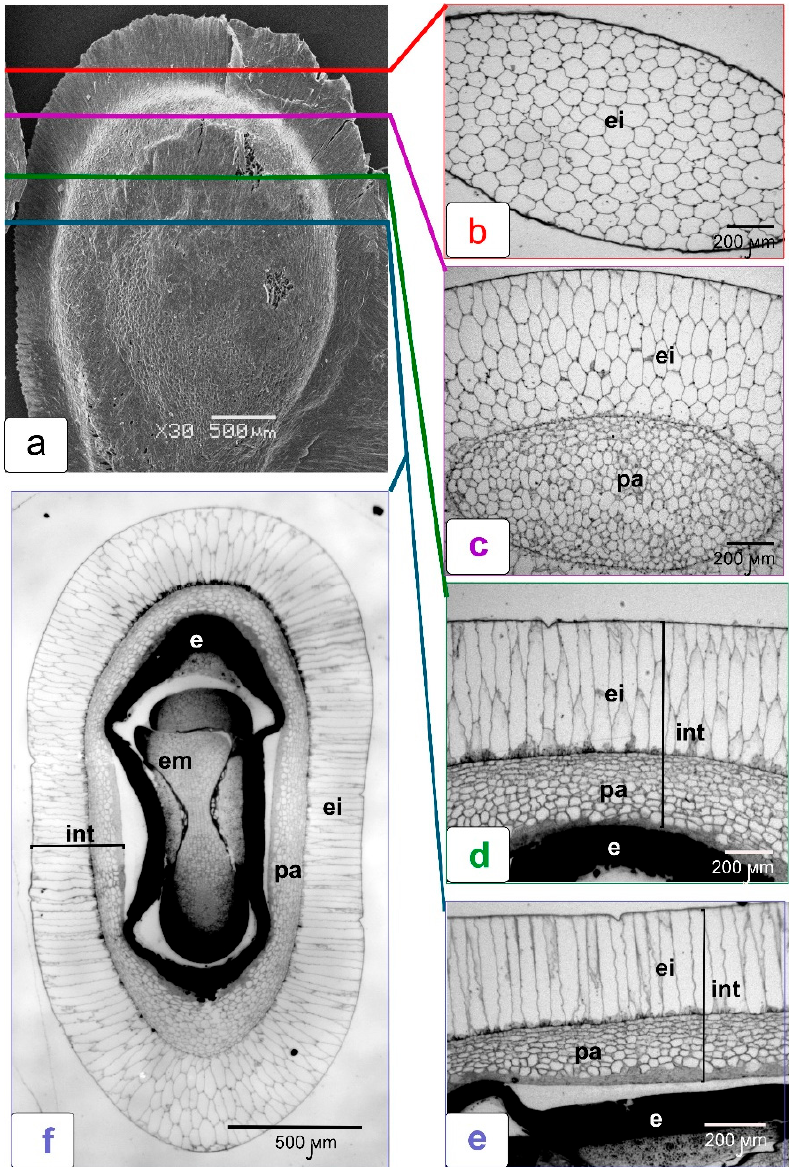
Figure 5. The light microscopy of the seed structure from a close-to-ripening green tomato fruit on cross sections. Sectioning locations (instead of a diagram) are shown in the seed image taken on scan ( a ). Transverse semi-thin sections of seeds (light microscopy) extracted from a ripening tomato fruit in different zones: a section passing through the epidermis of the integument in the upper part of the seed ( b ); a section passing through the parenchyma cells and epidermis of the integument ( c ); fragment of a transverse section, including the integument and tightly adjoining endosperm tissue ( d ); a fragment of a transverse section, including the integument and loosely adjoining endosperm tissue ( e ); a cross section of tomato seed in the embryo zone ( f ). Designations: e—endosperm; em—embryo; ei—outer epidermis of integument; int—integument; pa—parenchyma of